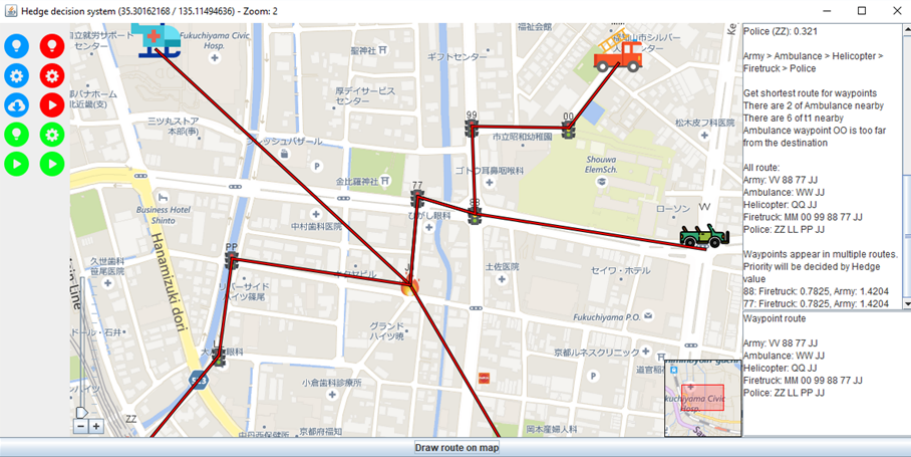
Figure 12. The route of transportation vehicles was appeared on the Google